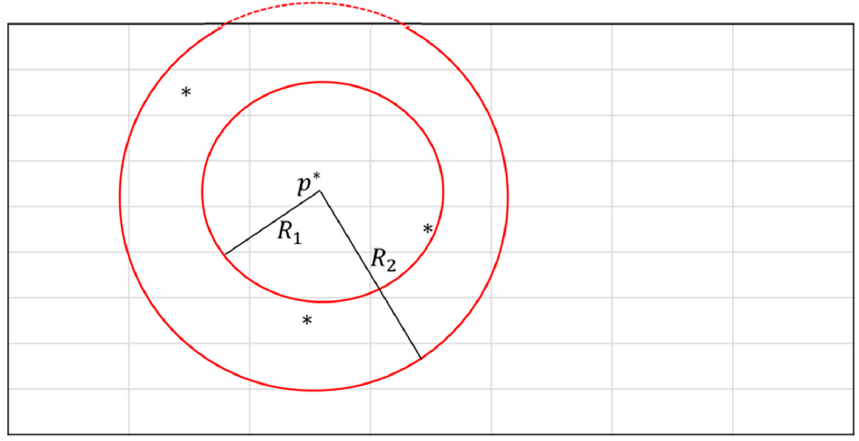
Figure 2. Example of cutoff areas (feedbacks are marked by *).